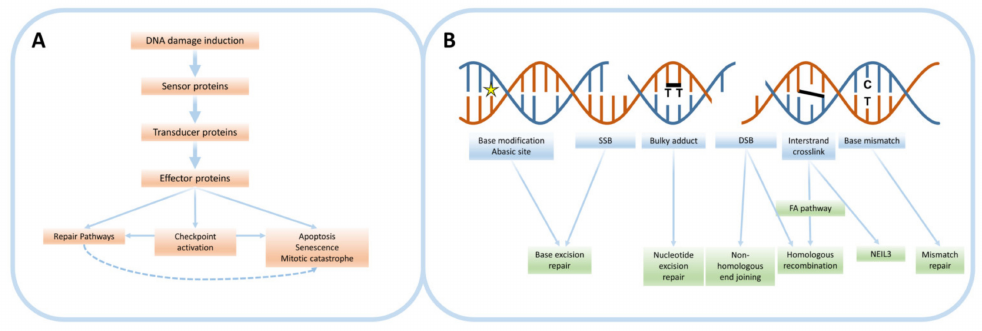
Figure 1. Overview of the DNA damage response. ( A ) General overview of the DDR signaling cascade upon DNA damage induction, either endogenously or by external agents. After damage detection by sensor proteins, transducer proteins activate e ff ector proteins that can elicit a variety of cellular responses. Cell cycle checkpoints will be activated to halt proliferation and allow time for (accurate) repair. However, the inability to repair the induced damage can also lead to induction of detrimental cellular fates such as apoptosis. ( B ) Visualization of types of DNA damage that can be induced, as well as the main pathways that are directly involved in their repair. Abbreviations: SSB: single-strand break; DSB: double-strand break; FA pathway: Fanconi anemia